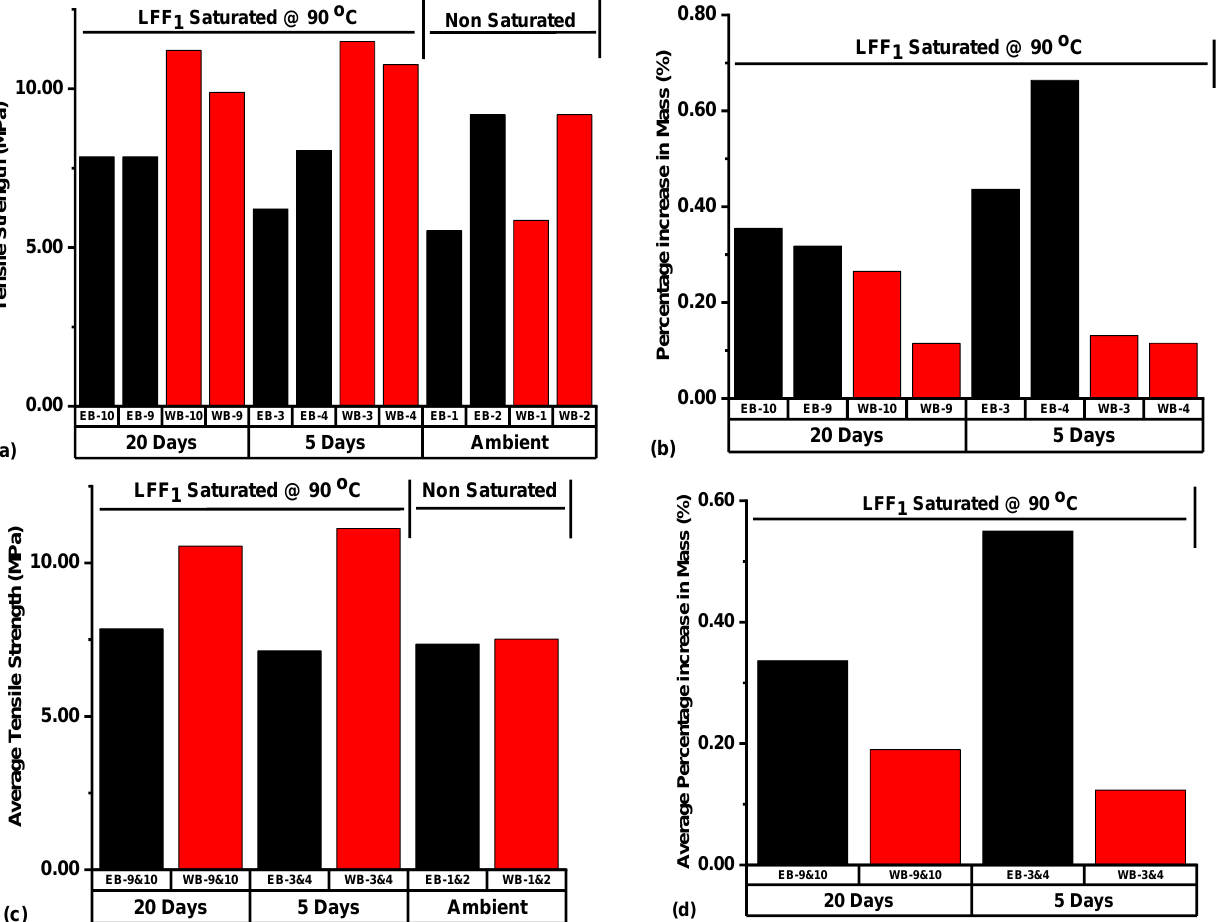
Figure 14. ( a ) Tensile strength, ( b ) Percentage increase in mass, ( c ) Average tensile strength (ATS), and ( d ) Average percentage increase in mass (APIM) of samples subjected to different treatment conditions prior to BITS testing. Notes: (1) Ambient samples were non-saturated and non-heated, and (2) All reported values were corrected to 2 decimal places after calculations, and, due to this, a reported average value may vary by 0.01 from the average value to be obtained using values already corrected to 2 decimal places.